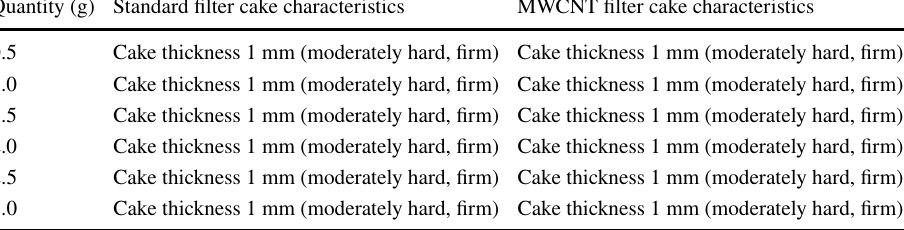
Table 5 Filter cake characterization for